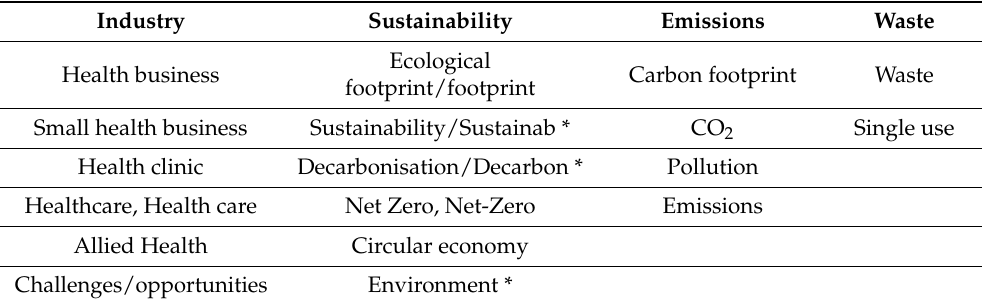
Table 1. Search terms used to conduct the structured literature